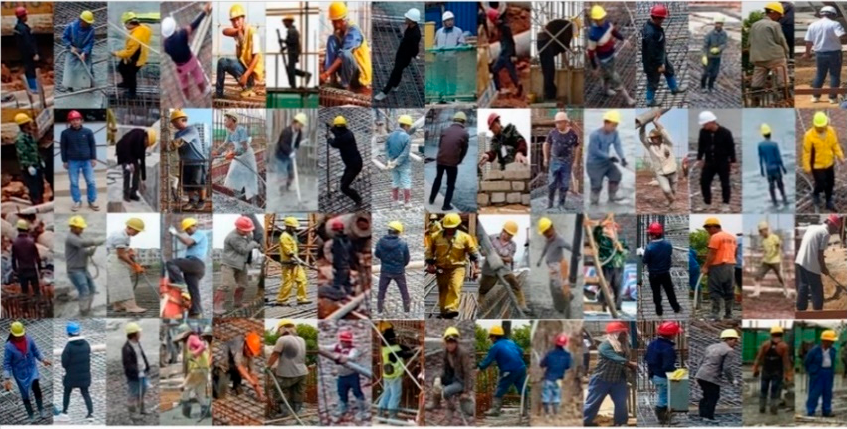
Figure 10. SVM training set.